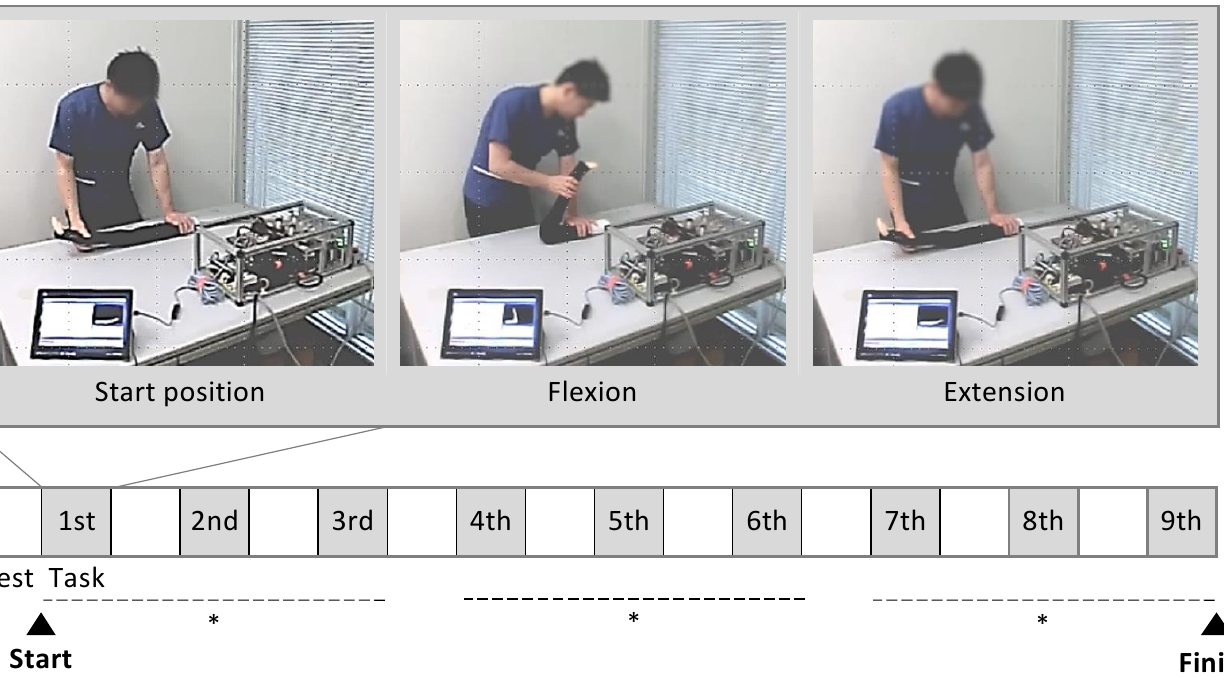
Figure 2. Therapist and student therapeutic motion data collection protocol. Gray and white boxes indicate time progression in tasks and intervals. The subject’s task involved flexing of the elbow joint from the maximum extension position to the maximum flexion position and back to the maximum extension position. Each subject performed nine tasks. The posture, grip position, holding method, and task execution speed were unspecified. The subjects were instructed to perform the therapeutic motion therapy suited to the muscle tone of SAMO. * The severity of muscle hypertonia (mild, moderate, and severe) was randomly set using the robot settings. (These photos are completely original. Written informed consent was obtained for publication by the subject in the photos.) .